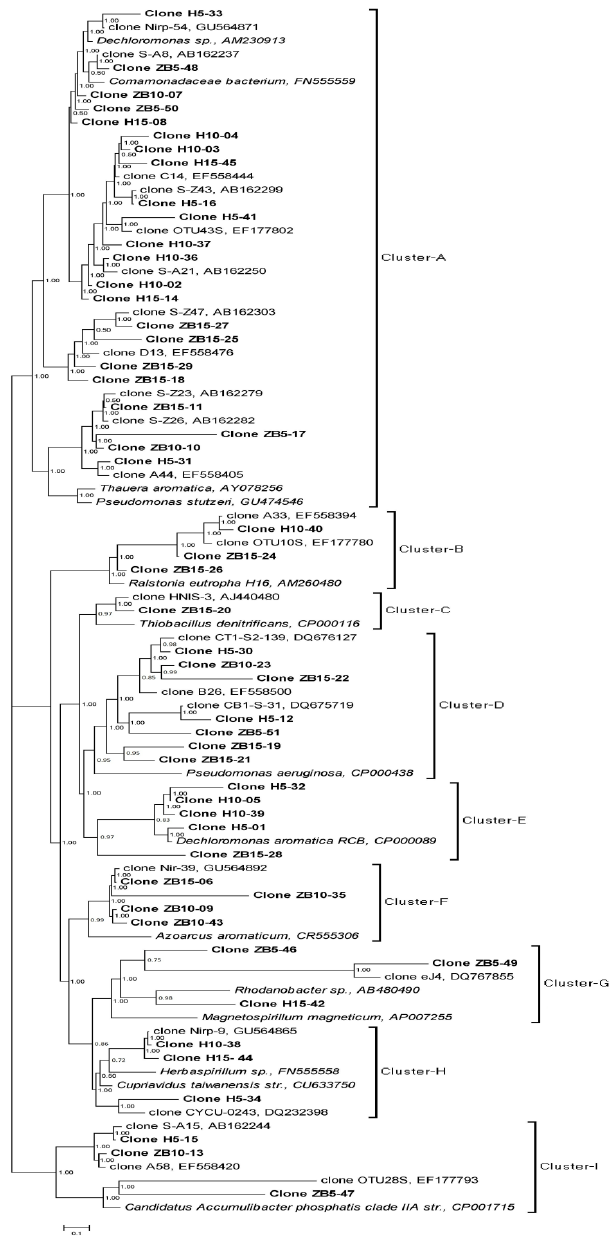
Fig. 1. Phylogenetic tree of PCR-amplified nirS gene. The tree was constructed using the Bayesian inference (BI) methods with nirS sequences from the Pearl River sediment and from other typi- cal estuarine and marine environments, as well as sewage treatment systems. Sequences determined in this study are in bold. Bootstrap values were based on 1000 replicates each and are shown at the nodes with > 50% bootstrap support. OTUs with bootstrap value either > 80% were utilized to designate the nirS phylogenetic clus- ters. The scale bar represents 10% sequence